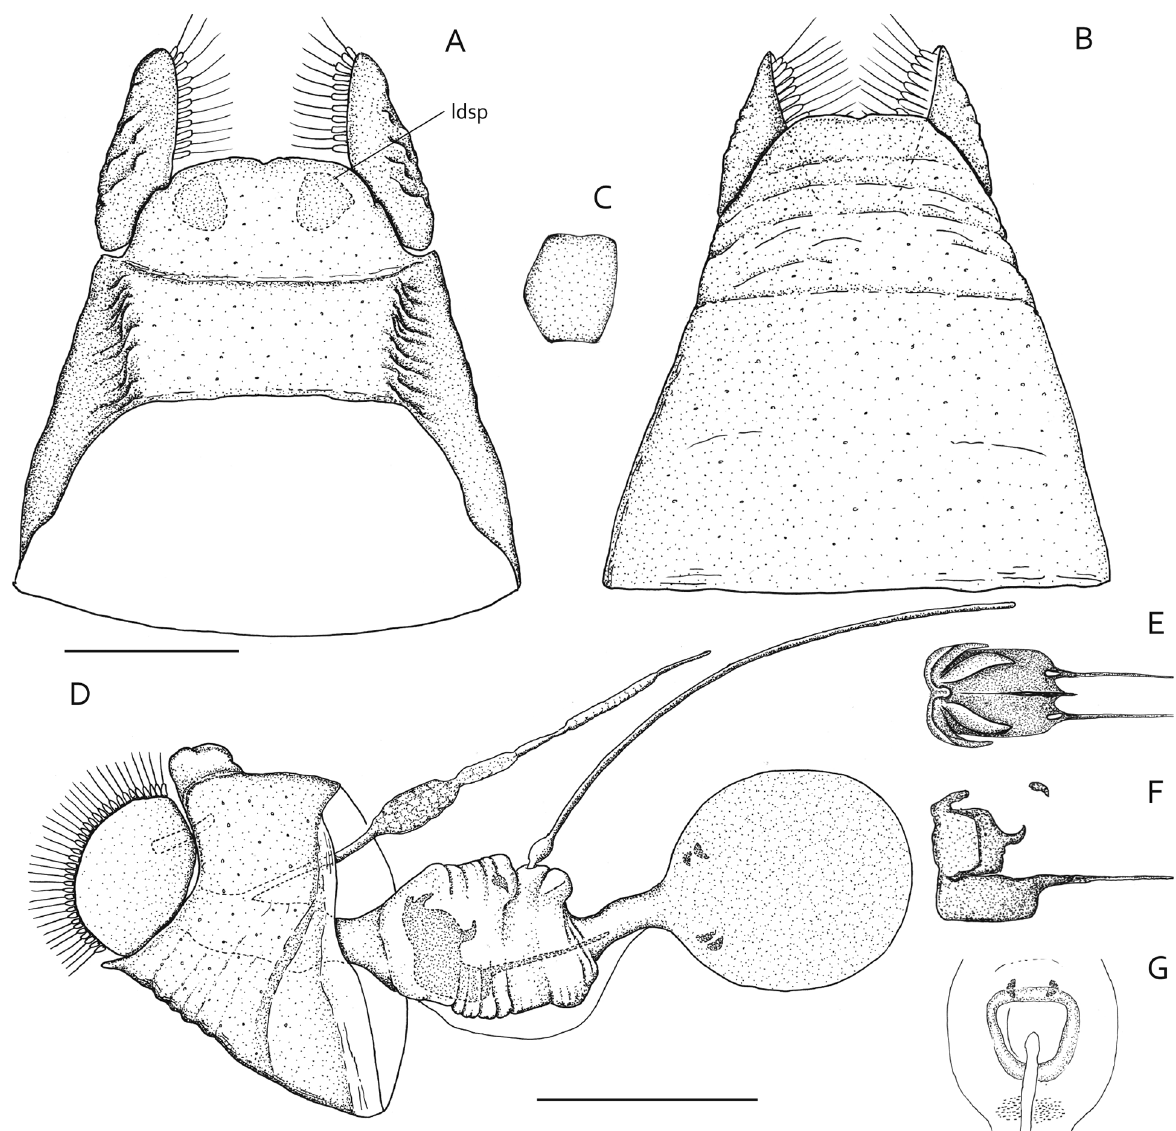
Figure 7. Female genitalia of Melinopteryx bilobata sp. n. [paratype]. A: genitalia capsule, dorsal view; B: ditto, ventral view; C: a lobe of dorsal sclerotized plate of Segment X, dorsal view; D: female genitalia, lateral view; E: genital sclerite, dorsal view; F: ditto, lateral view; G: arising part of ductus spermathecae, dorsal view. Scale bars: 0.2 mm. Abbreviation: ldsp = two lobes of dorsal sclerotized plate of segment